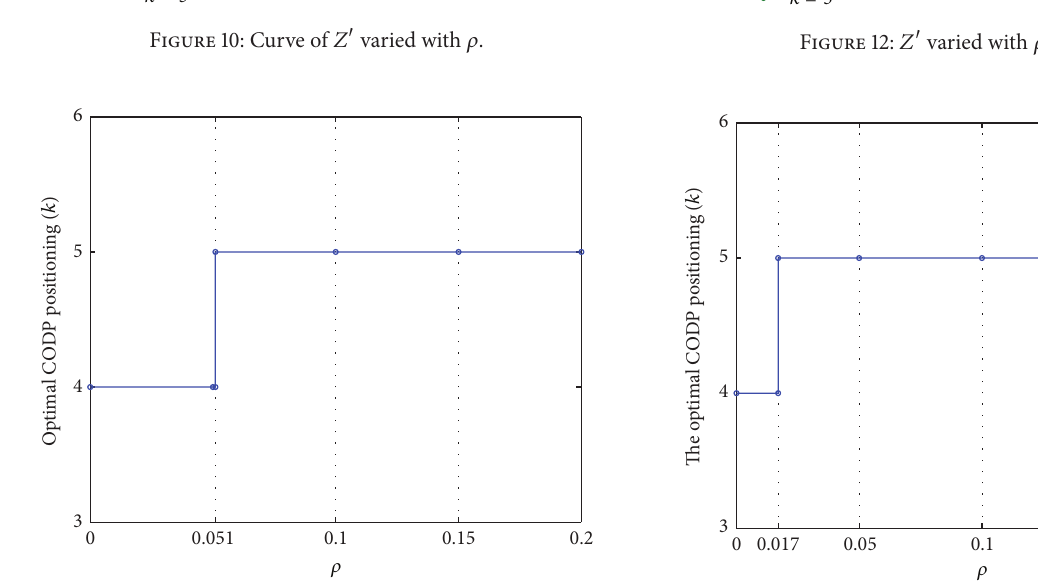
Figure 11: Curve of optimal CODP varied with 𝜌 .